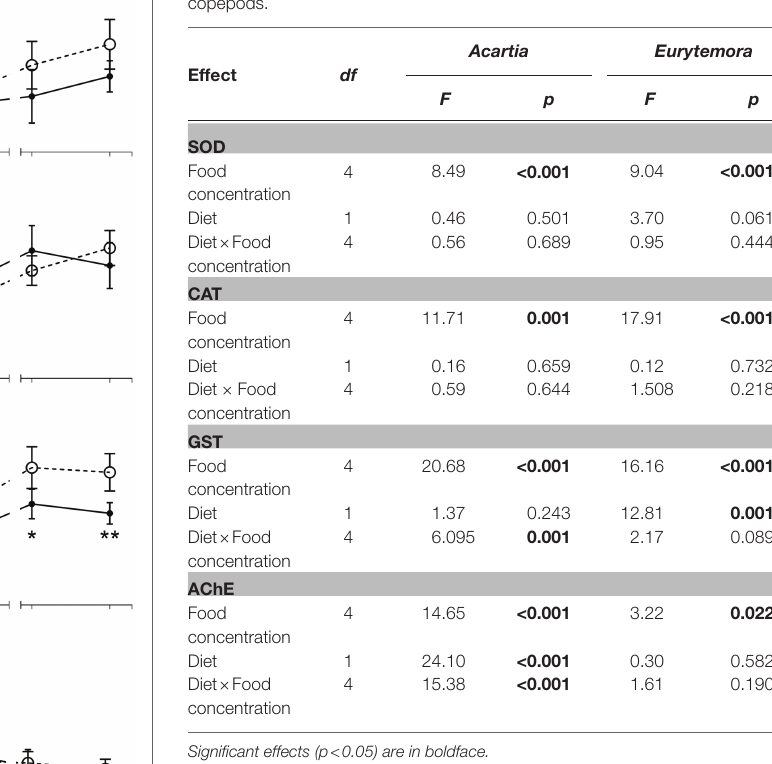
TABLE 1 | Two-way ANOVA; sigma-restricted parameterization, effective hypothesis decomposition: diet ( Nodularia/Rhodomonas vs. Rhodomonas ) and food concentration (0, 5, 25, 125, and 300 μ g C L − 1 ) effects on SOD, CAT, GST (U mg protein − 1 ), and AChE (nmol AcSCh min − 1 mg protein − 1 ) activities in